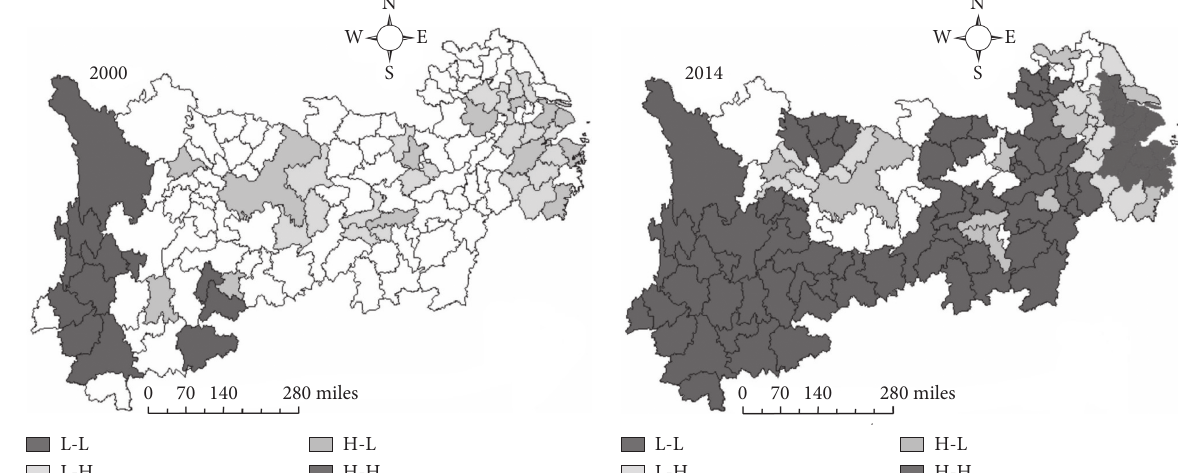
Figure 1: Spatial co-relation of innovation in Yangtze Economic Belt.